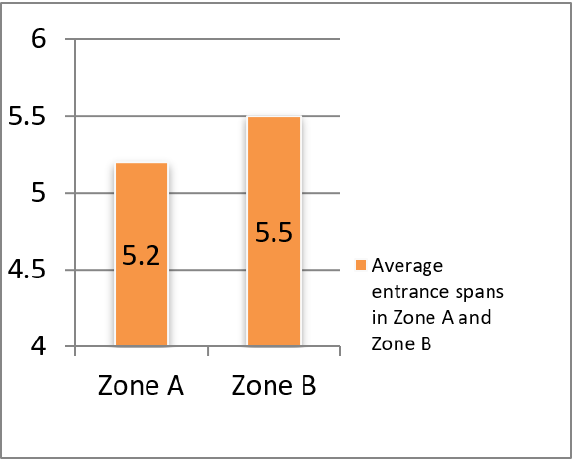
Figure 31. Average entrance spans of rooms in Zone A and Zone B.